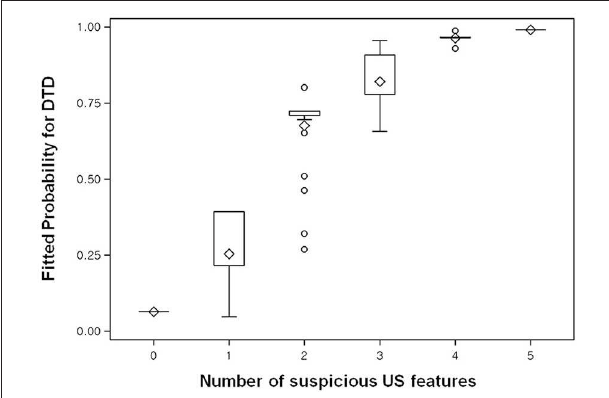
FIGURE 3 | Box plot shows the fitted probabilities of diffuse thyroid disease (DTD) calculated with logistic regression by using the ultrasonography (US) features of thyroid parenchyma in the 270 patients. Probabilities are shown according to number of abnormal US features (x-axis). The lower and upper ends of the vertical lines are the minimum and maximum values of the probability of DTD, respectively. The upper horizontal line of each box represents the 75th percentile of the data set, while the lower horizontal line represents the 25th percentile. The points in the box indicated by ♦ are mean values. Lower and upper horizontal lines outside the boxes represent the 10 and 90th percentiles of the dataset, respectively. Circles represent outliers.